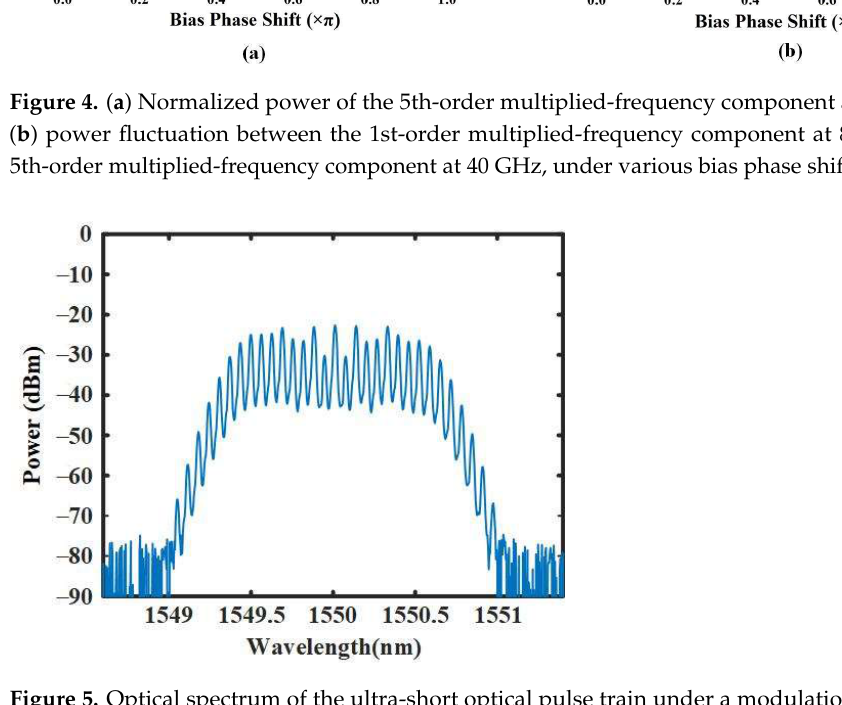
Figure 5. Optical spectrum of the ultra-short optical pulse train under a modulation index of 0.7π and a bias phase shift of 0.7π.